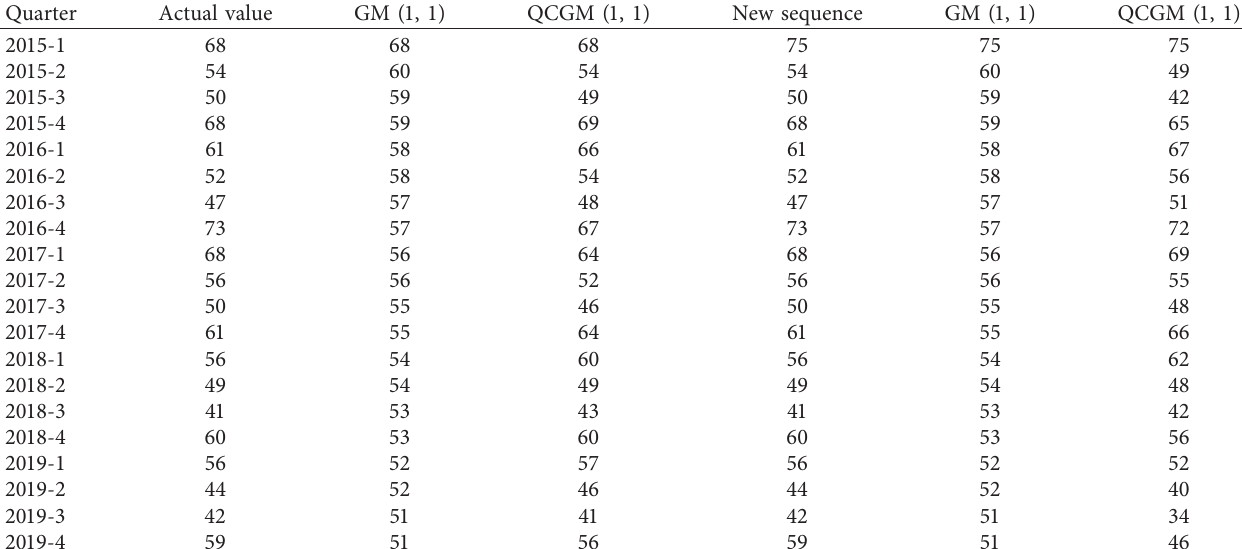
Table 4: The fitting results of the two models (unit: μ g/m 3